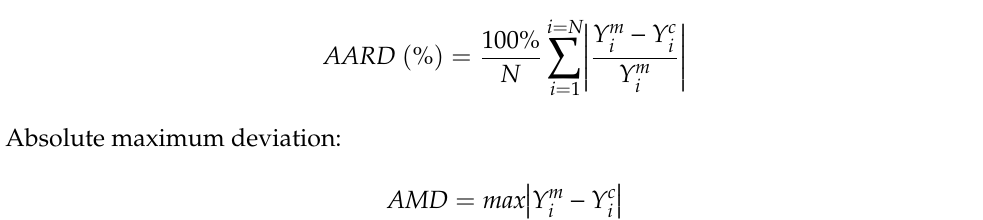
‘ □ ’; DMEA in (DMEA + H 2 O), ‘ ◊ ’ and DEEA in (DEEA + H 2 O), ‘ ∆ ’ at 353.15 K.